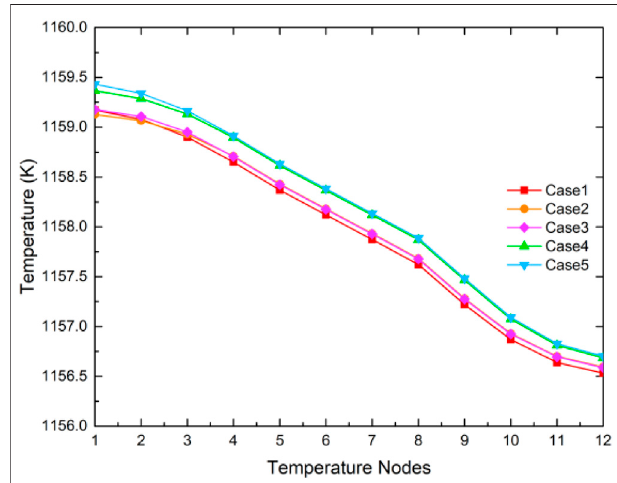
FIGURE 18 | Pressure variation in circulation. FIGURE 19 | Wall temperature distribution in different cases (1).